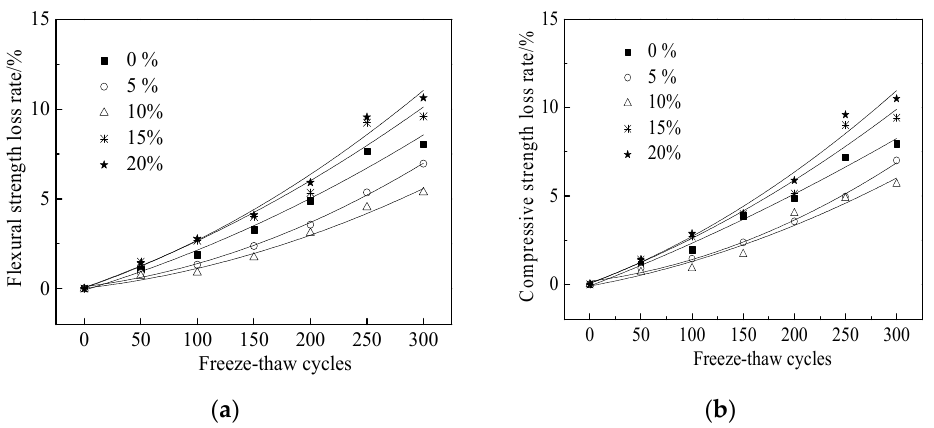
Figure 6. Relationship between the mechanical strength loss rates of RPC with WFA and NaCl freeze–thaw cycles: ( a ) flexural strength ( f t ) loss rate; ( b ) compressive strength ( f cu ) loss rate.